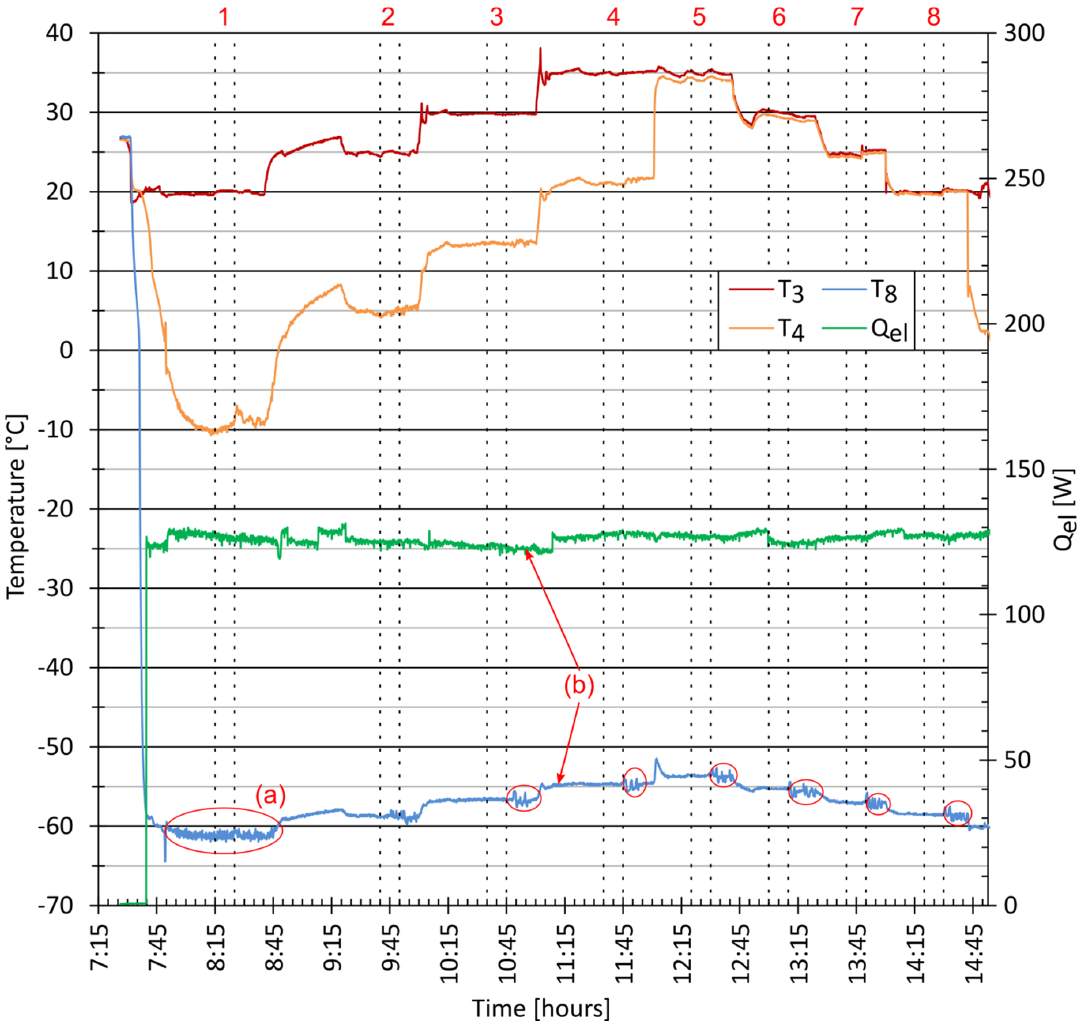
8:05 with a corresponding condensing temperature, T 3 , of 20 8:25 were selected as the first result of the experimental series. The condensing temperature, T 3 , was gradually changed until it reached the value of 35 and numbered from 1 to 8. Energies 2020 , 13 , x FOR PEER REVIEW